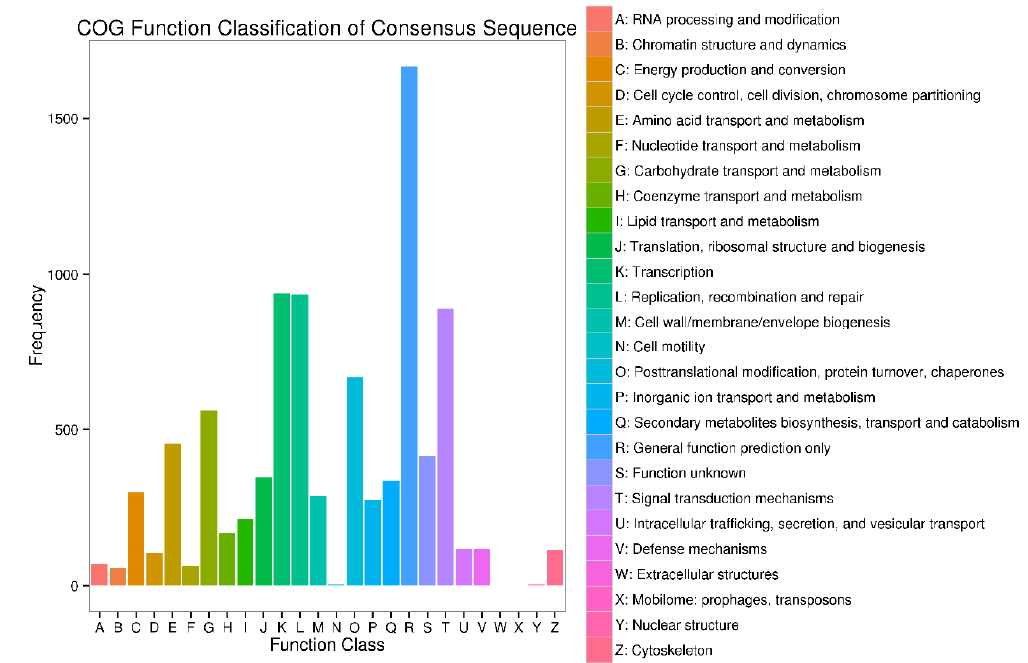
Figure A2. COG function classification of the annotated DEGs between the two individuals numbered S05 and S11. The horizontal axis represents the COG categories and horizontal axis represents the gene number.